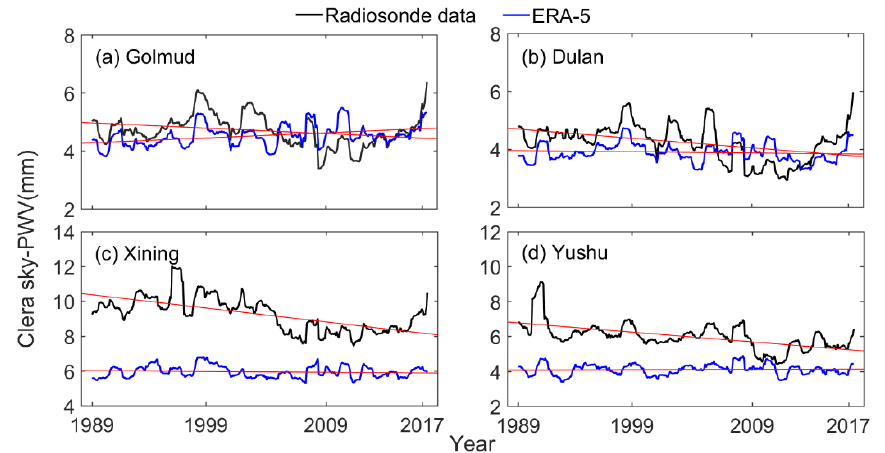
Figure 10. Change trend of the 12-month moving average of monthly PWV under clear sky condition at different stations. ( a ) Golmud station ( b ) Dulan station ( c ) Xining station ( d ) Yushu station